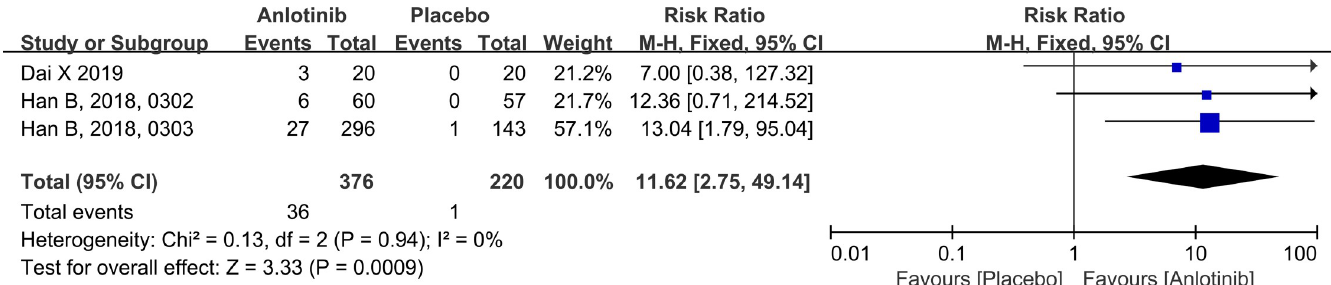
Fig 5. Forest plot comparing the ORR between anlotinib and placebo group in advanced NSCLC. The blue squares represent the RR of a study, and the black line their confidence intervals. The black diamond represent the pooled RR and its confidence interval.